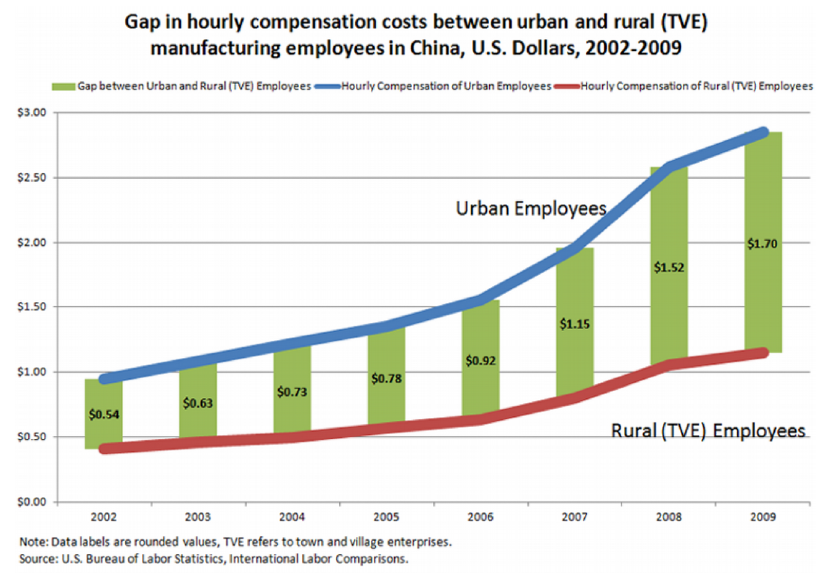
Figure 9. China rural versus urban